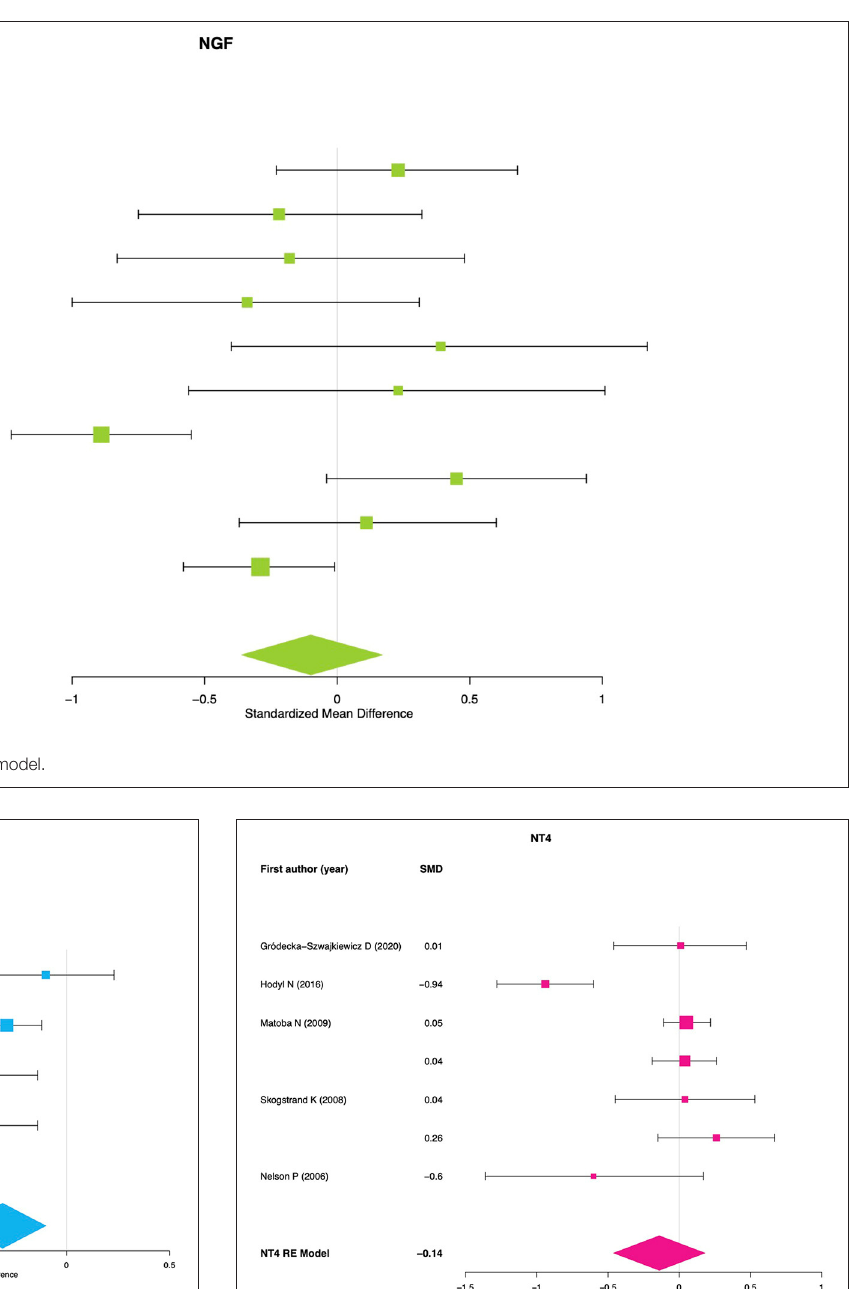
FIGURE 4 | NT-4 meta-analysis. RE, random effects